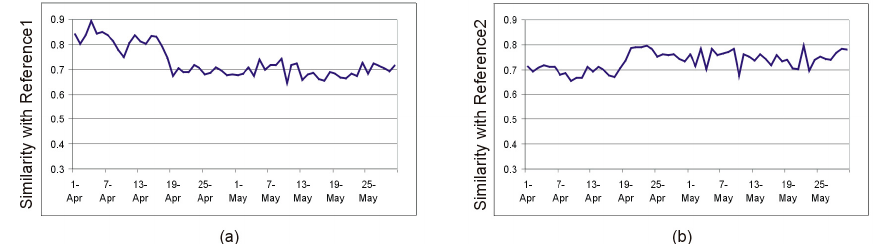
Figure 10. ( a ) The similarity index after comparison with a reference interval before 18 April 2014. ( b ) The similarity index after comparison with a reference interval after 18 April 2014.